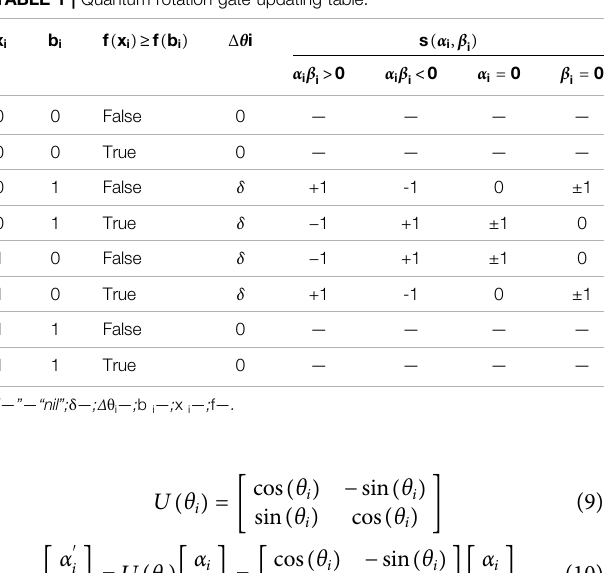
TABLE 1 | Quantum rotation gate updating